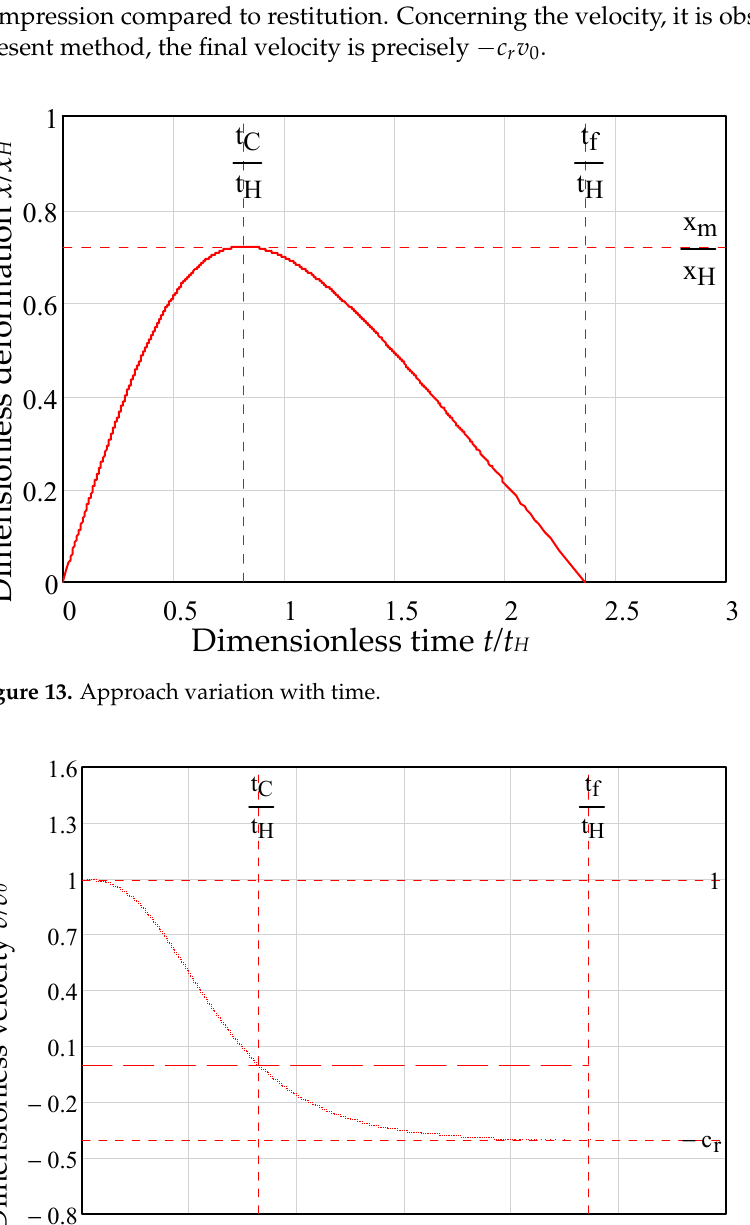
Figure 12. Dependence of times on the order number of the points.